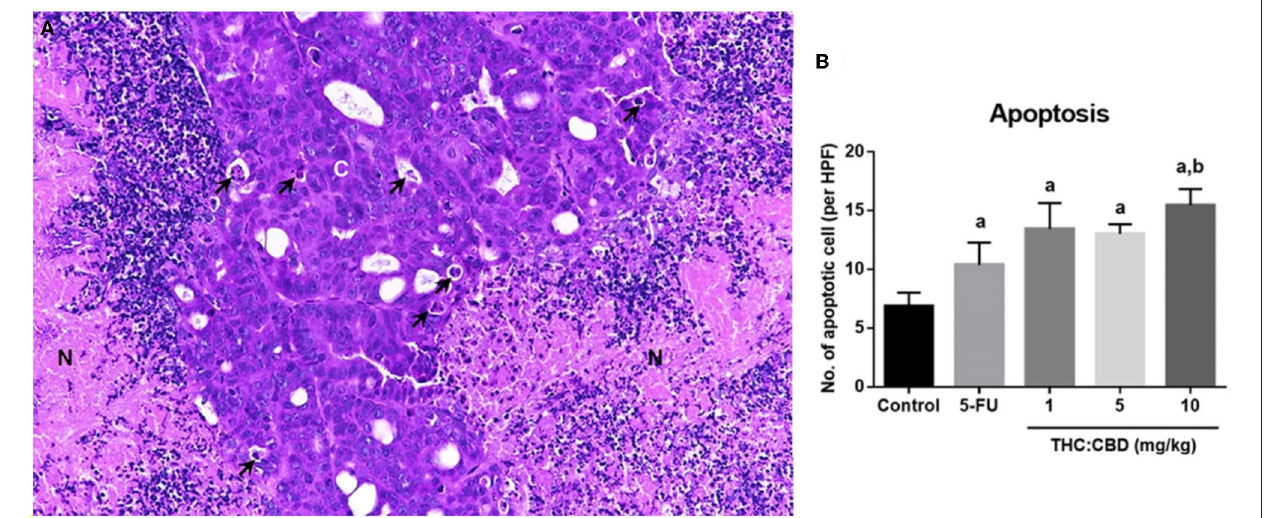
FIGURE 5 | Histopathological morphology of pancreatic adenocarcinoma of mice gavaged with THC:CBD. The tumor demonstrated scattered apoptotic cells (arrow) with necrotic tissue (N) (A) (HE, 20 × ). The graph demonstrated the average apoptotic cells per high-power field in the negative control group, the positive control group (5-FU), and THC:CBD at the dose of 1, 5, and 10 mg/kg BW. Data were expressed as mean ± SD. a indicates a significant difference at P < 0.05 compared to the negative control group. b indicates a significant difference at P < 0.05 compared to the positive control group (5-FU) (B) .